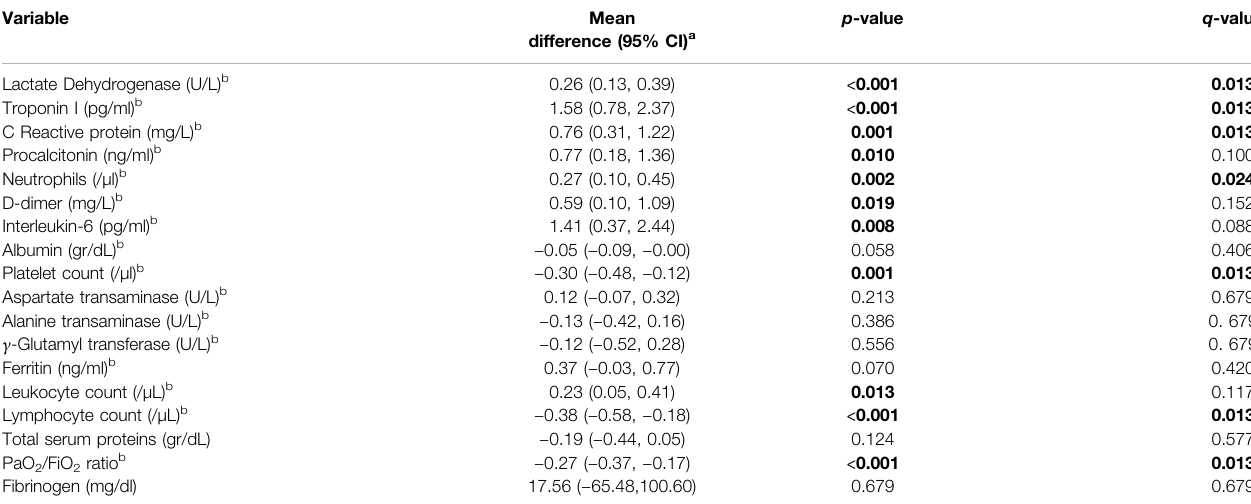
TABLE 3 | Mean differences in the biochemical markers and hemogram parameters between individual with COVID-19 according to the vital status.